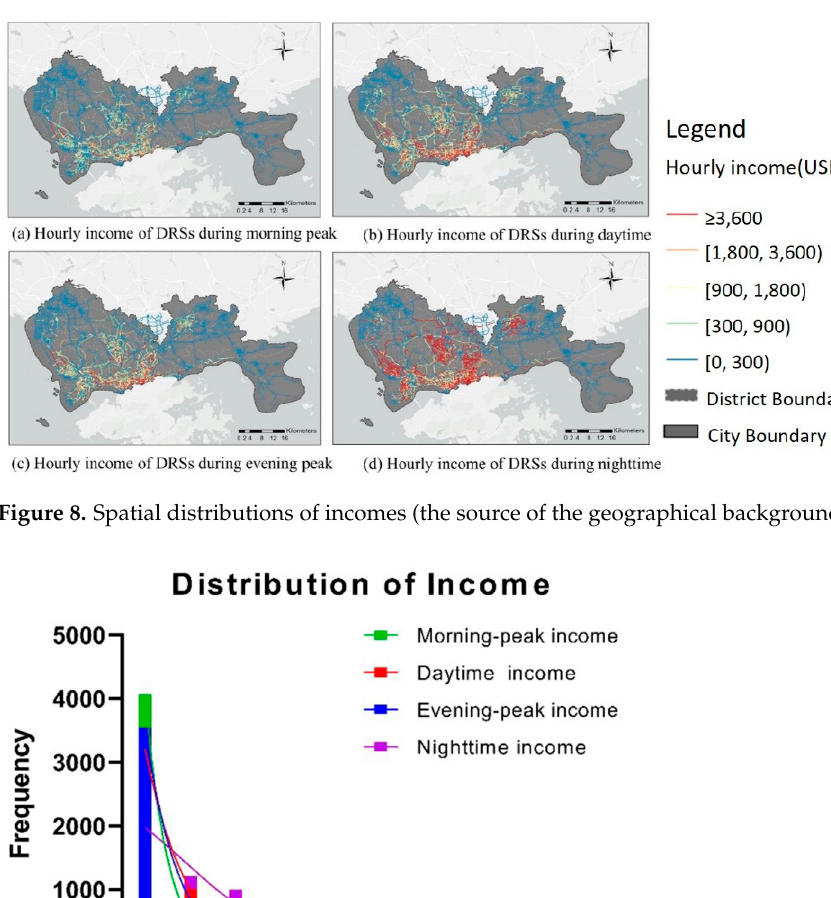
Figure 7. Trend diagram for speed on DRSs.